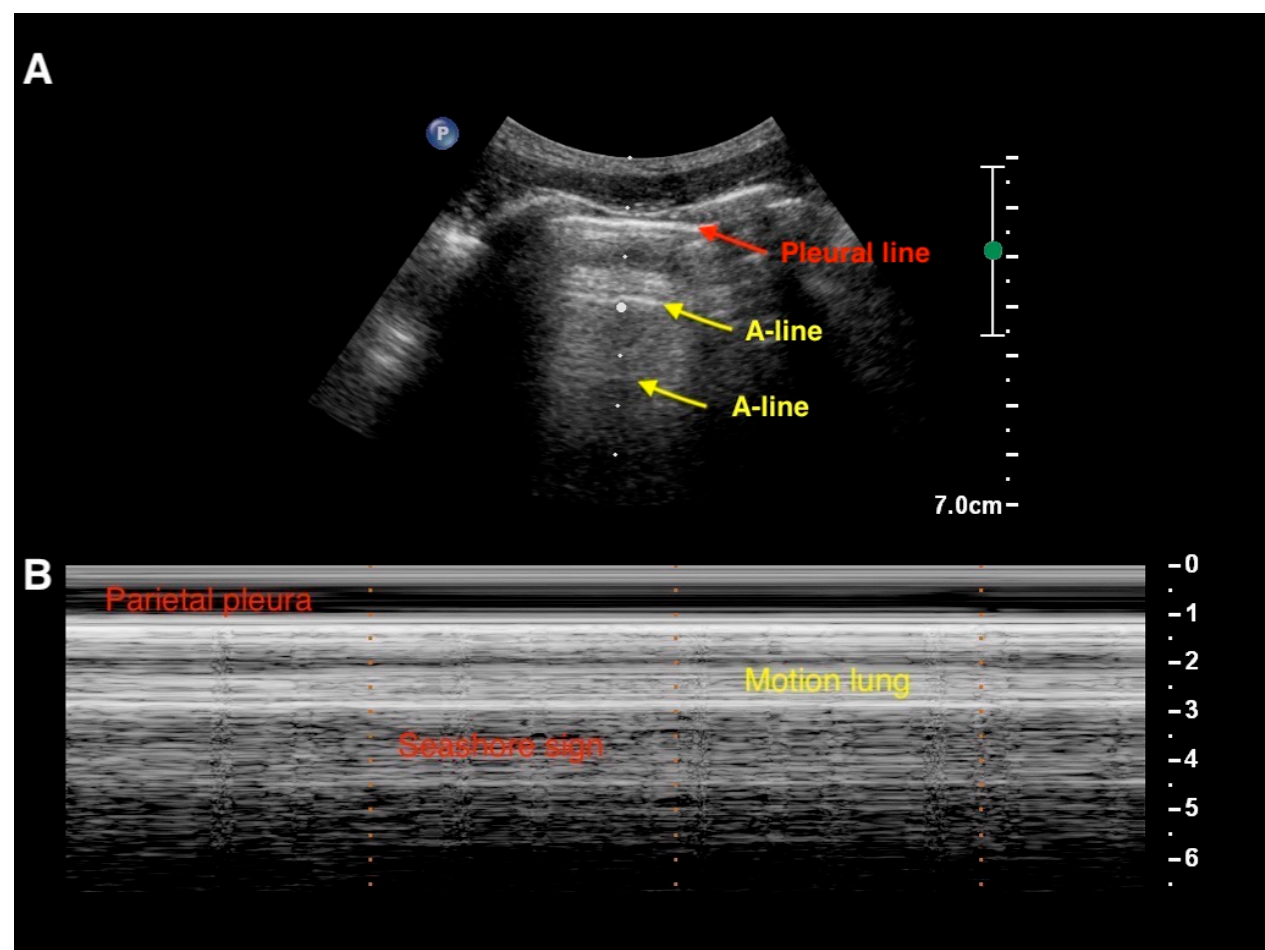
Figure 7. Basic signs of lung ultrasound in B- and M-mode, normal lung. ( A ) In B-mode, the red arrow indicates the pleural line (horizontal echogenic line under subcutaneous tissue). The pleural line can be observed moving with respiratory movement. The yellow arrows represents the horizontal A-lines. ( B ) The M-mode demonstrates normal pleura sliding: subcutaneous tissues above the pleural line do not move away or toward the probe and are represented as straight lines. The pattern below the pleura is an artifact deriving from visceral pleura sliding, as it generates a sandy pattern called the “seashore